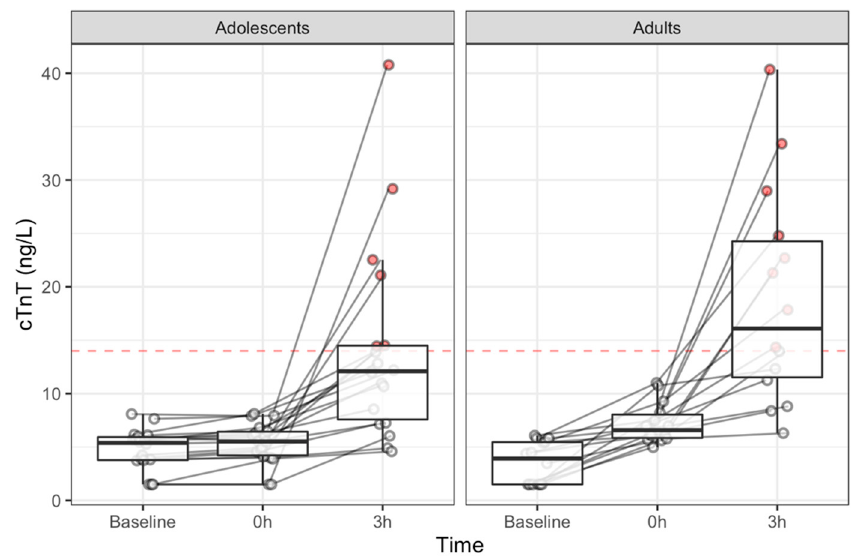
Figure 1. Individual points of cTnT by group. Red horizontal line and red dots denote the cutoff value for myocardial infarction (MI) of 13.5 ng/L and above values, respectively.